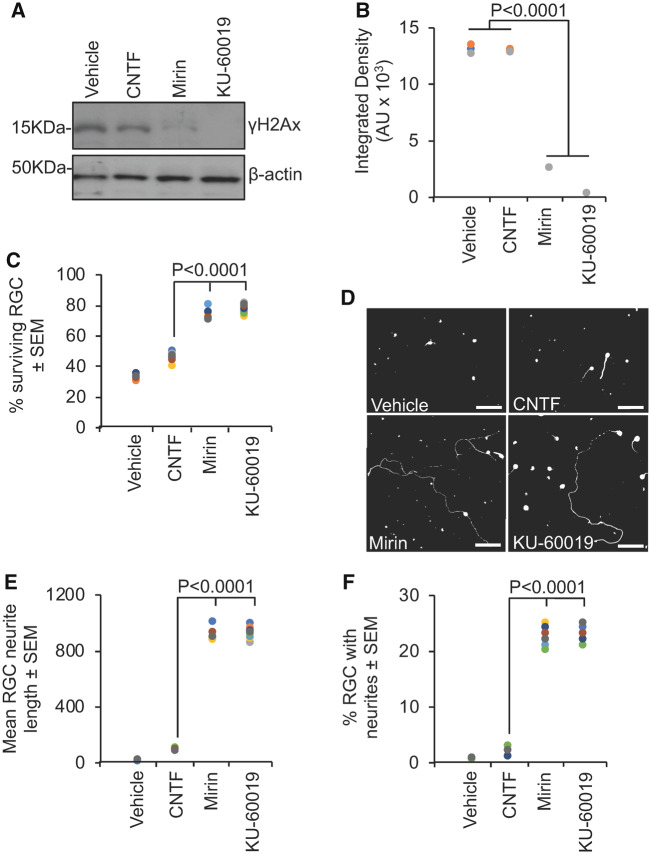

Inhibition of Mre11 prevents RGC apoptosis and stimulates neurite outgrowth after 4 days in culture in the presence of inhibitory CNS myelin extracts. (A) Western blot and (B) subsequent densitometry to show attenuated levels of anti-γH2Ax after treatment with mirin and KU-60019. (C) Mirin or KU-60019 significantly enhanced RGC survival. (D) Representative images from RGC treated with vehicle, CNTF (positive control), mirin and KU-60019. Mirin or KU-60019 treatment (E) increased the mean RGC neurite length and (F) % RGC with neurites. n = 3 wells/treatment, three independent repeats (total n = 9 wells/condition). AU = arbitrary units. Comparisons in B, C, E and F by one-way ANOVA with Dunnett’s post hoc test. Scale bars in D = 100 µm.